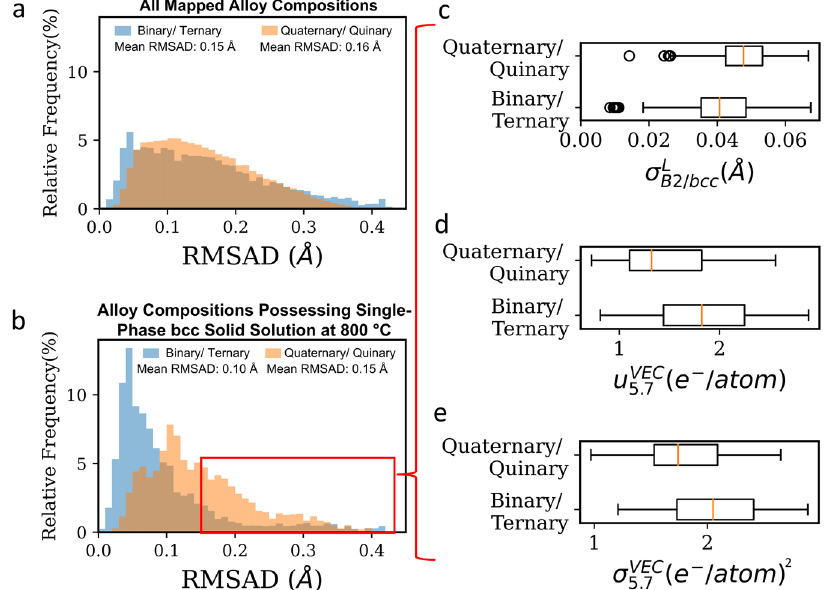
Fig. 6 Distribution of lattice distortion in bcc refractory solid-solution alloys. Relative frequency histograms of lattice distortion in the alloys ( a ) before and ( b ) after screening for single-phase stability at 800 °C. The histogram colored in blue corresponds to the distribution of the RMSAD parameter of the binary and ternary alloys, while the histogram associated with the quaternary and quinary alloys is colored in orange. c – e Boxplots describing the distribution of physical descriptors that contribute to RMSAD in the alloys with severe lattice distortion (i.e., alloys with RMSAD > 0.15